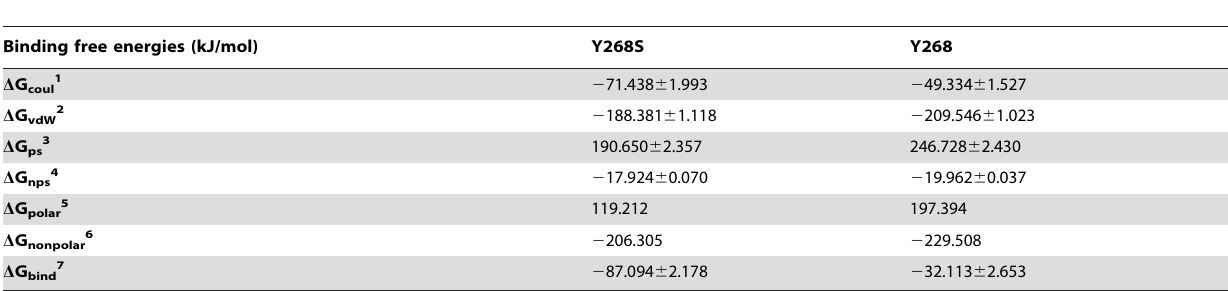
Table 1. MM/PBSA binding free energies (kJ/mol) of wild-type and mutant Cyt bc1/ATQ complexes.